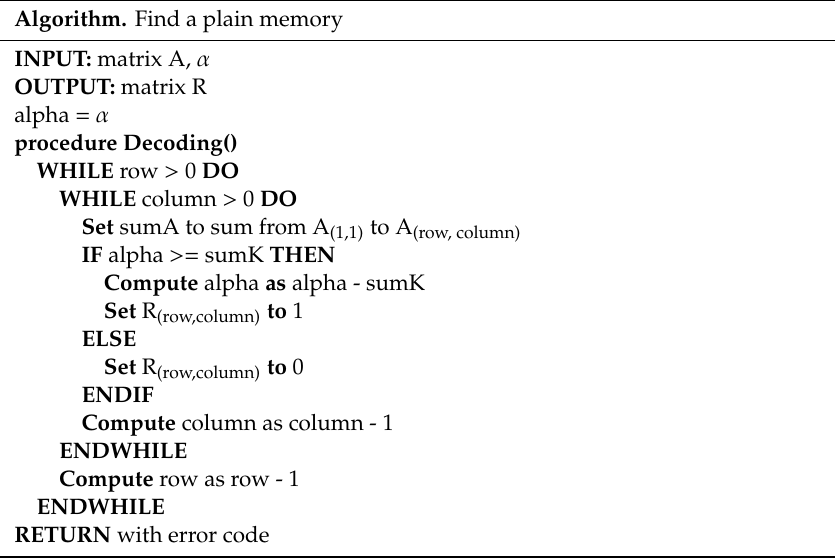
Table 1. Decoding procedure of proposed